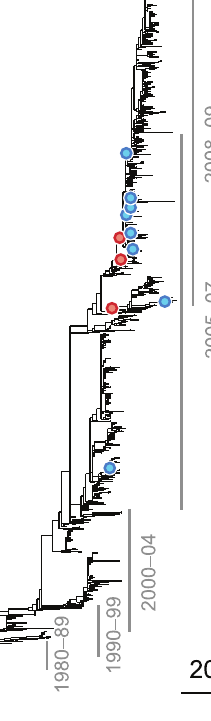
Figure 3. Phylogenetic tree of NA (subtype N1) illustrating a putatively epistatic interaction between the leading site 344 (red circles) and the trailing site 275 (blue circles). Other notations are as in Figure 2.